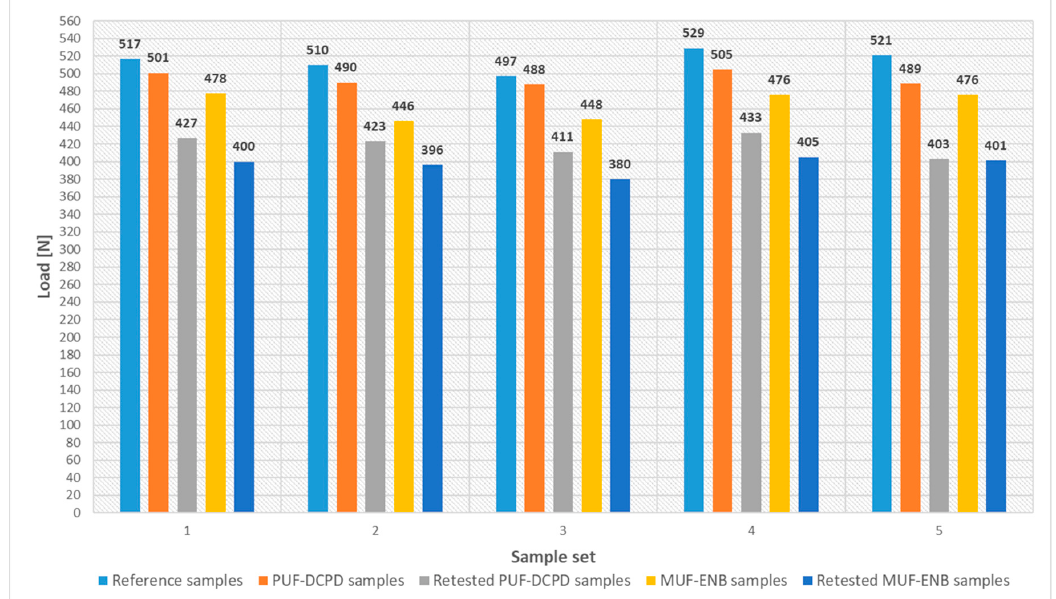
Figure 28. Load values for the three-point bending tested specimens.